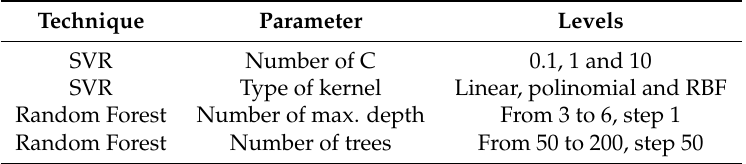
Table 2. Machine-learning parameters and